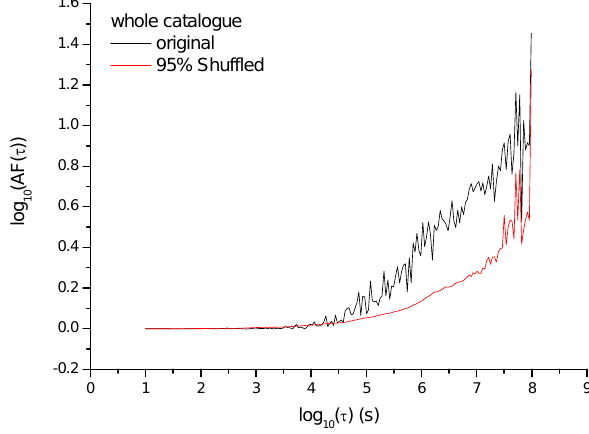
Fig. 7. Comparison between the AF curve for the full catalogue (black line) and the 95% confidence curve (red line) obtained by means of generation of 1000 randomly shuffled